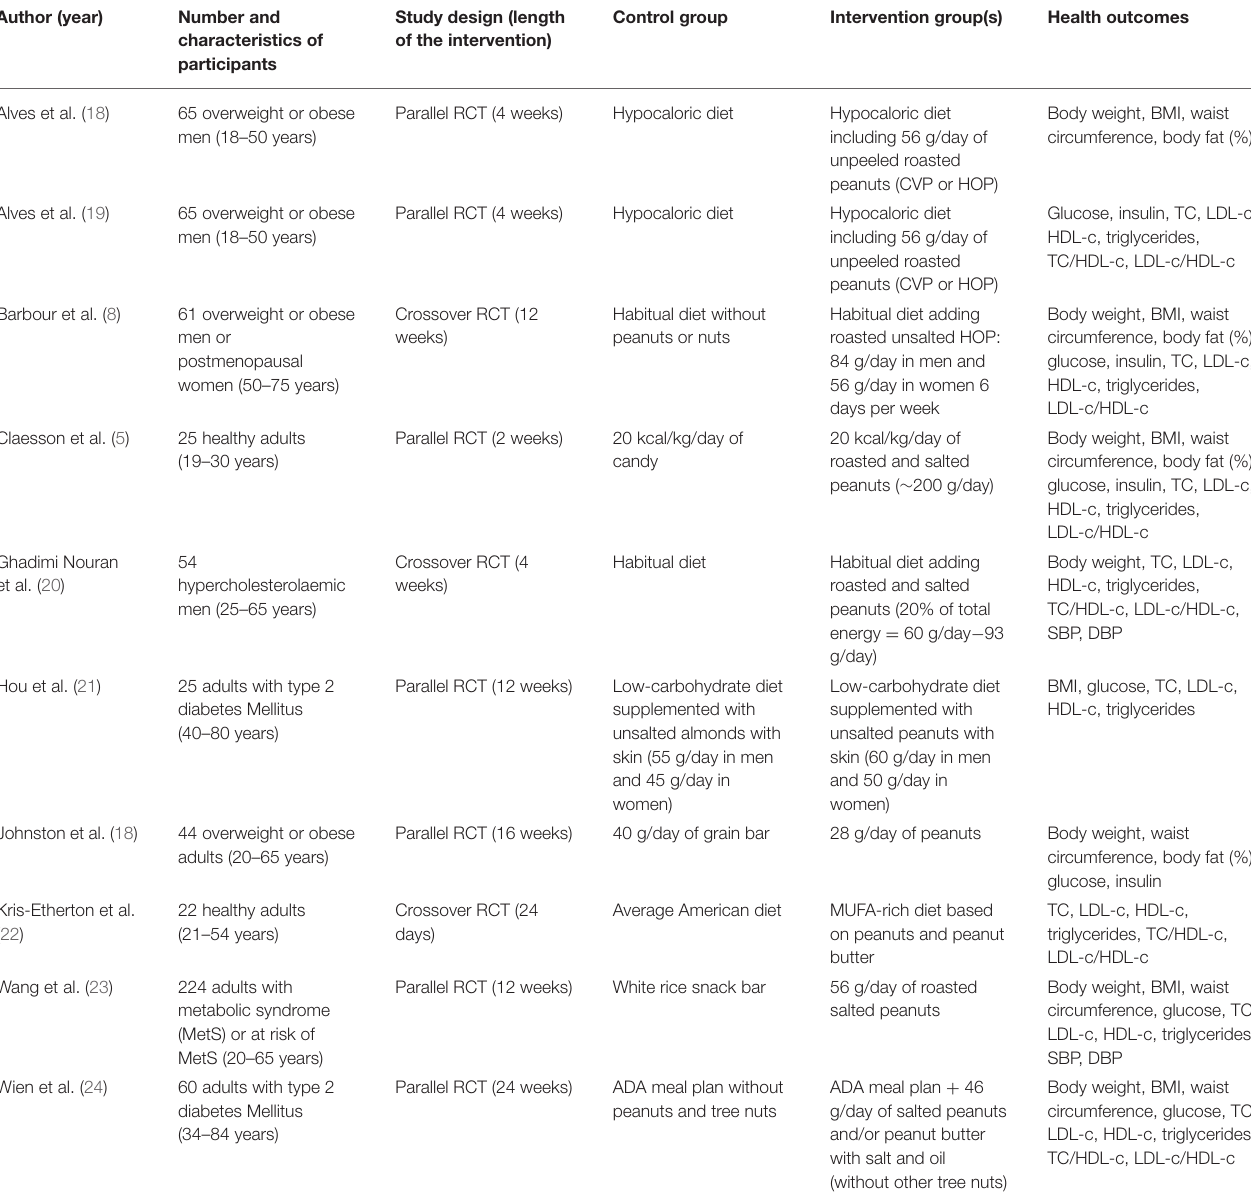
TABLE 3 | Summary of studies included in the systematic review and meta-analysis evaluating the effect of peanut product intake on health